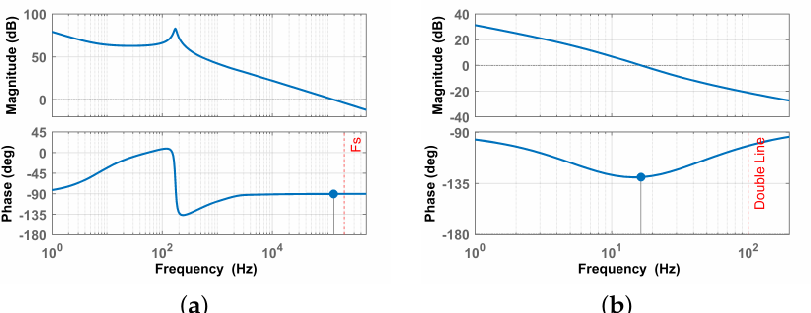
Figure 14. Bode plots transfer functions for boost loop gain of: ( a ) Current loop Gi L 1 d _ u _ RC ( s ) G Ci ( s ) . ( b ) Voltage loop G vi